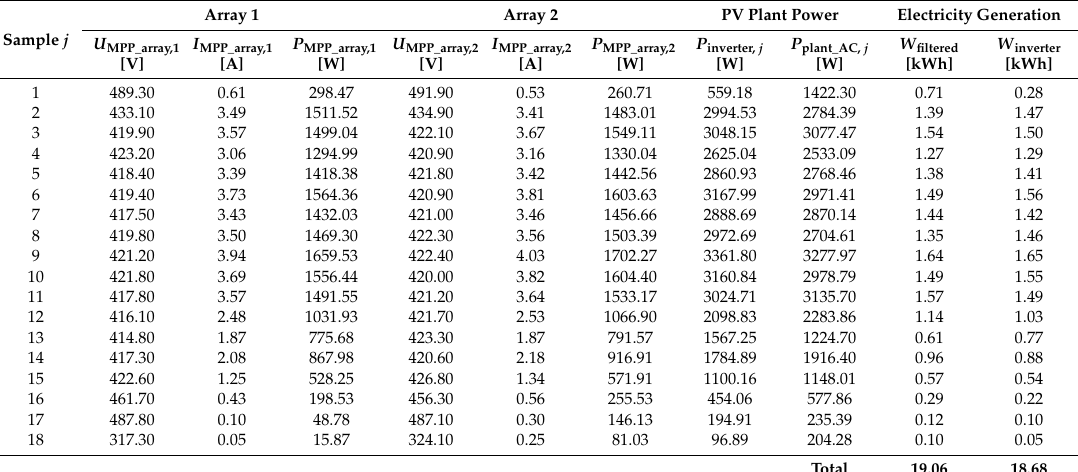
Table 4. Results of fast PV power emulation of the 6 kW PV plant made of Masdar MPV100-S PV modules for 2 September 2018.